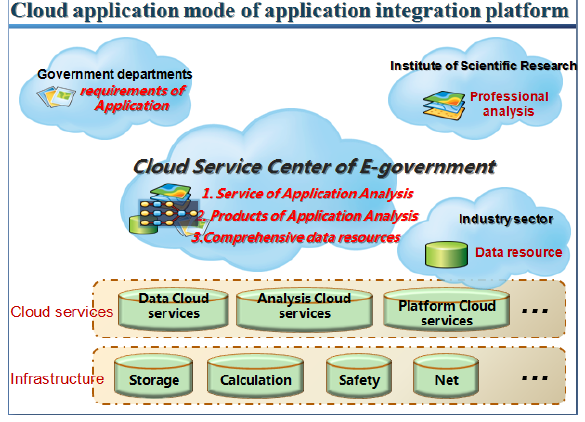
figure 1. Cloud application mode of application integration platform